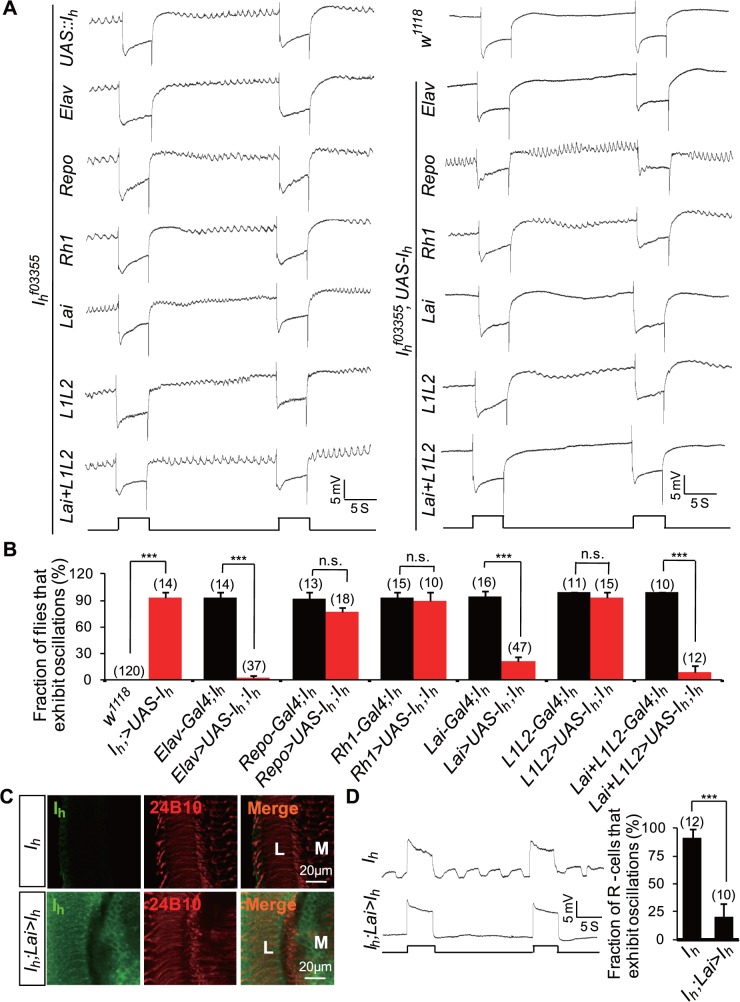
Expression of Ih channels in ACs restores a normal ERG response.(A) Expression of Ih channels in ACs suppresses ERG baseline oscillation. Ih channels were expressed using anatomically restricted GAL4 drivers. Flies possessed one copy of the indicated drivers. (B) The fraction of flies that exhibit the ERG oscillation phenotype in each genotype. The number of recorded flies for each genotype is listed. (C) Expression of Ih channels in I
h mutant (top) and I
h;Lai-GAL4/UAS—I
h (bottom) flies. Dissected whole brains were stained with anti-Ih (green) and anti-24B10 (red) antibodies. L, lamina; M, medulla. (D) Intracellular recordings of photoreceptors show that Ih channels expression in ACs suppresses rhythmical depolarization without light stimulation. The fractions of photoreceptors that exhibit rhythmic depolarization are presented in the right panel, and the numbers of recorded photoreceptors for each genotype are listed.